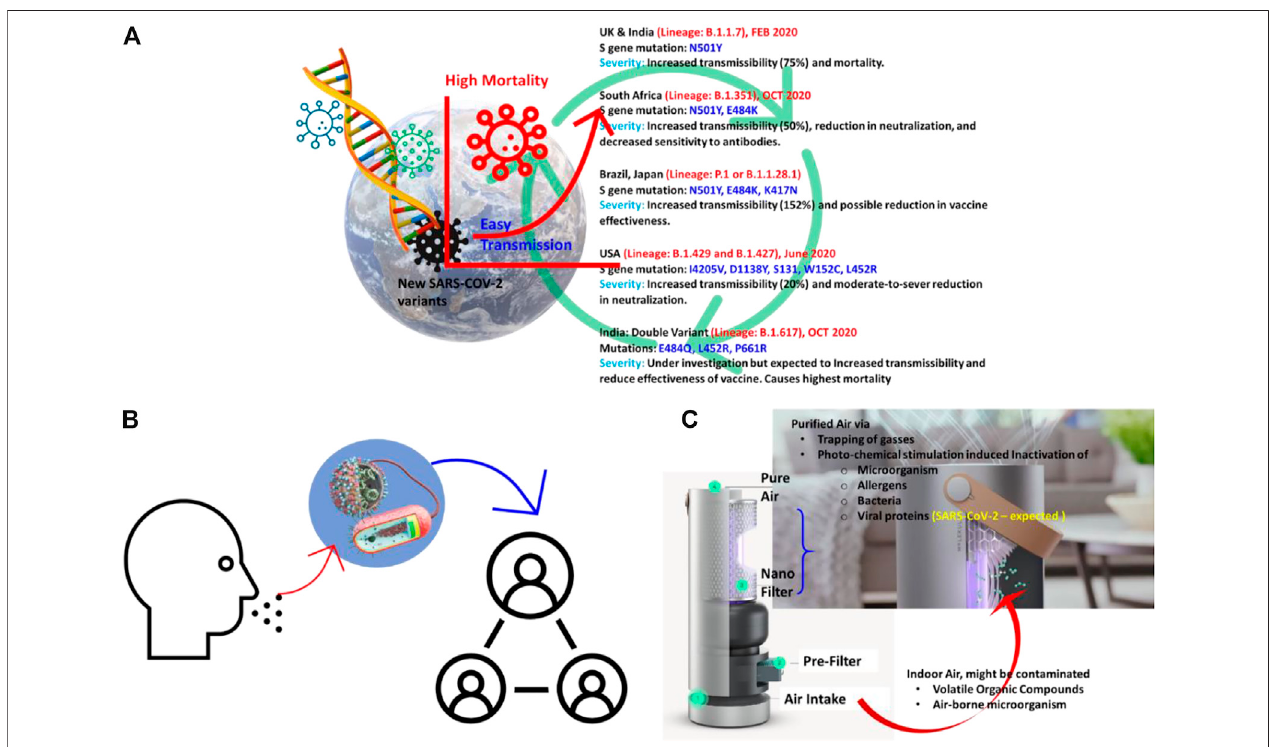
FIGURE 1 | Illustration of (A) SARS-COV-2 mutation concerning new variants and their severe effects, (B) transmission of new mutated SARS-CoV-2 in the community, and (C) approach to eradicate virus droplets from the air, especially in indoor air, using an air puri fi er consisting of a nanoparticle-based fi lter.